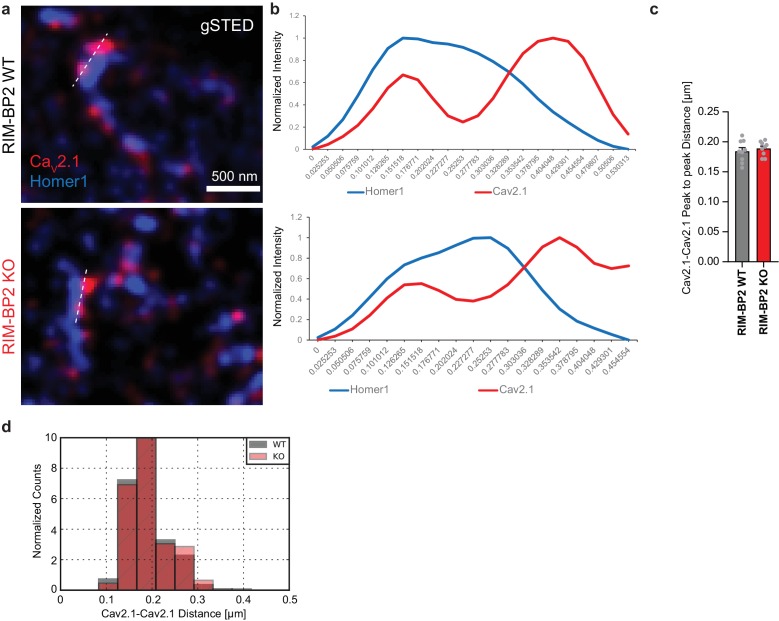
RIM-BP2 deletion does not alter P/Q type Ca2+-channels localization at MF synapses.(a) in situ gSTED images of Cav2.1 and Homer1 at MF synapses in RIM-BP2 WT and KO mice. Dotted line represents an example of a synapse analyzed by line profile measurement. Line profile thickness was set to ~250 nm. (b) Intensity line profiles of the synapses displayed in (a). For display, intensity in each channel was normalized to its maximum after background subtraction. We analyzed 24–35 line profiles per mouse (n = 9 mice/genotype). (c) inter-Cav2.1 distances found averaged per mouse analyzed. (d) Frequency histogram for all inter-Cav2.1 distances found. Counts were normalized to obtain a probability density function with an integral equal 1. No significant difference between RIM-BP2 WT and KO mice was observed. Values represent mean ± SEM. For statistics please see Figure 2—figure supplement 1—source data 1.10.7554/eLife.43243.006Figure 2—figure supplement 1—source data 1.Statistics of data presented in Figure 2—figure supplement 1.